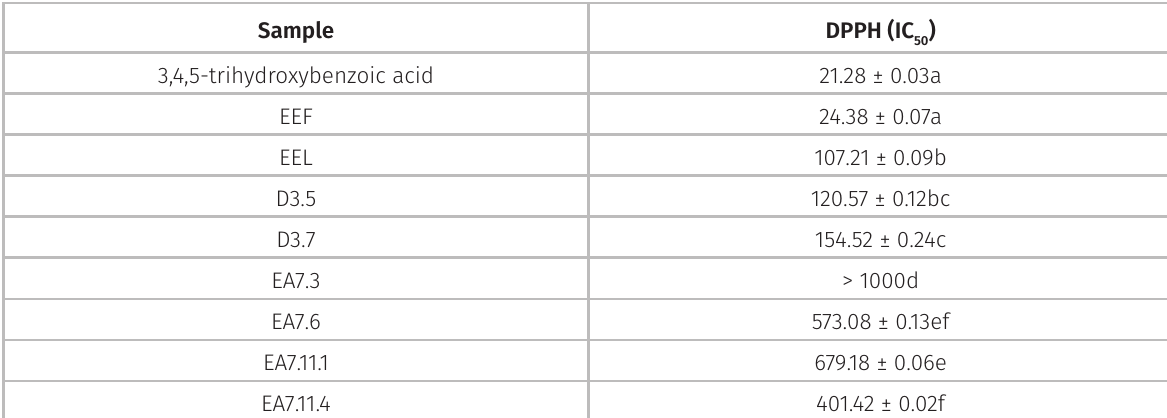
Table II. Scavenging activity (mean ± SD), expressed as inhibitory concentration (μg mL-1), in the DPPH test with extracts and sub-fractions of Banisteriopsis laevifolia